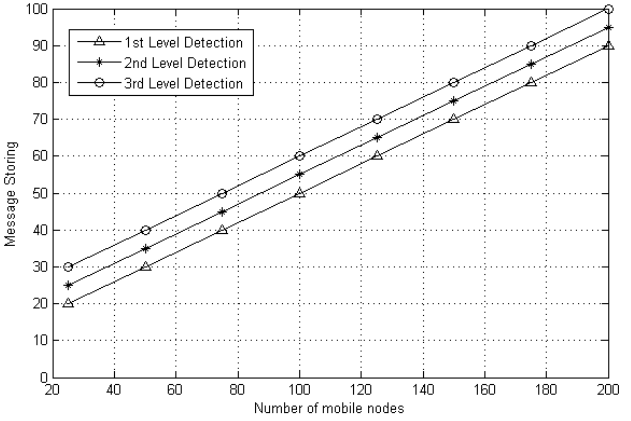
Figure 8. Message storing of DT approach.